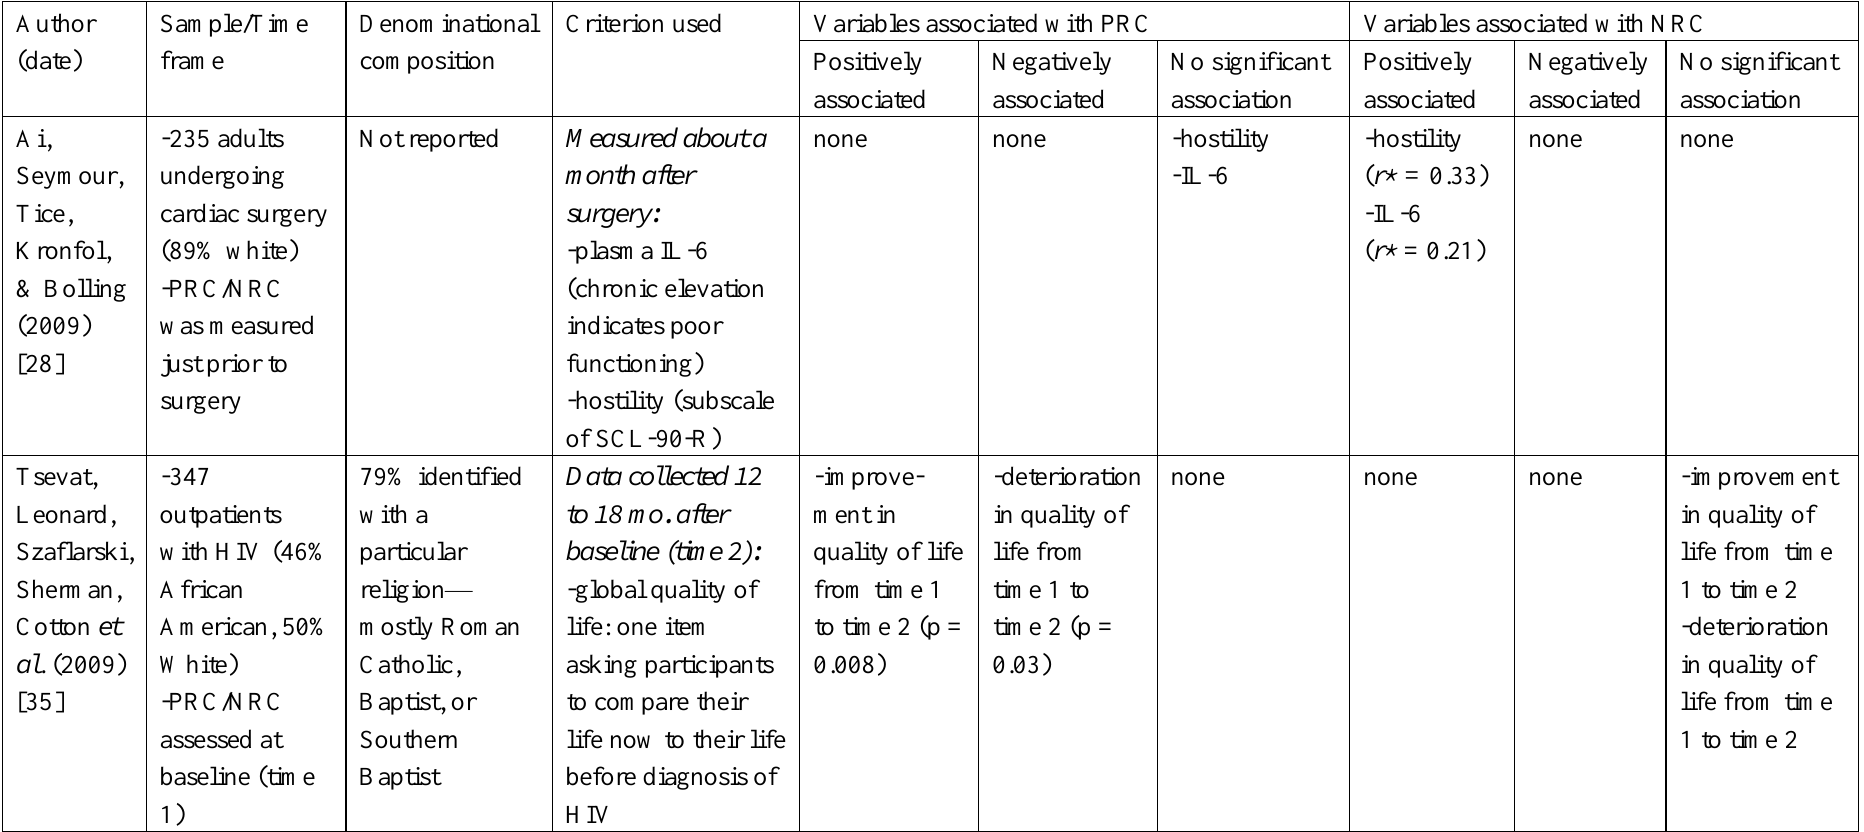
Table 4. Predictive